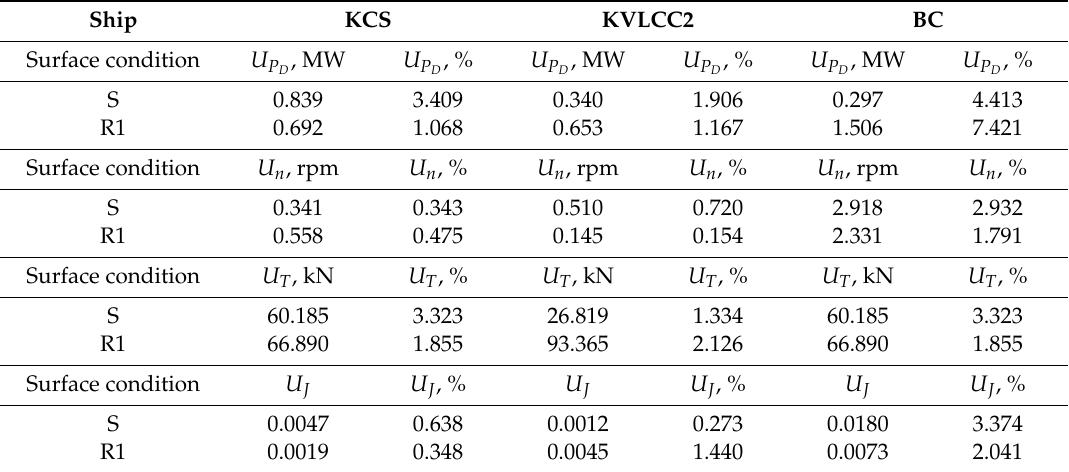
Table 9. The obtained simulation uncertainties ( U SN ) in the prediction of P D ( U P (cid:16) (cid:17) U J and J